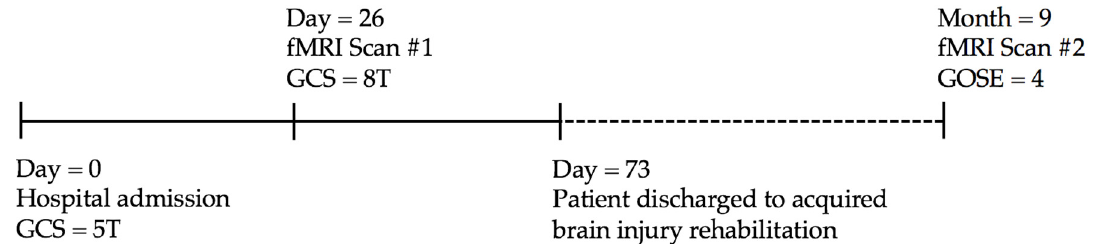
Figure 2. Schematic timeline of the patient from acute care admission to the follow-up fMRI scan. Written, informed consent was obtained from the patient ′ s substitute decision-maker for the first fMRI scan and subsequently, from the patient once consciousness and capacity were regained.